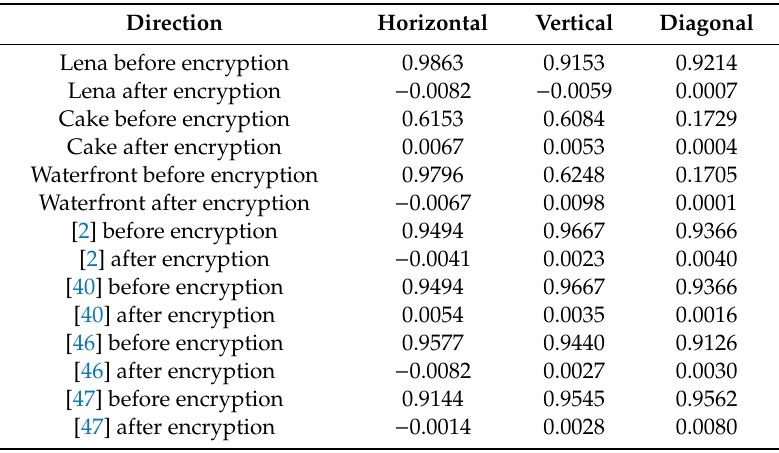
Table 2. Correlation Coe ffi cient Analysis.